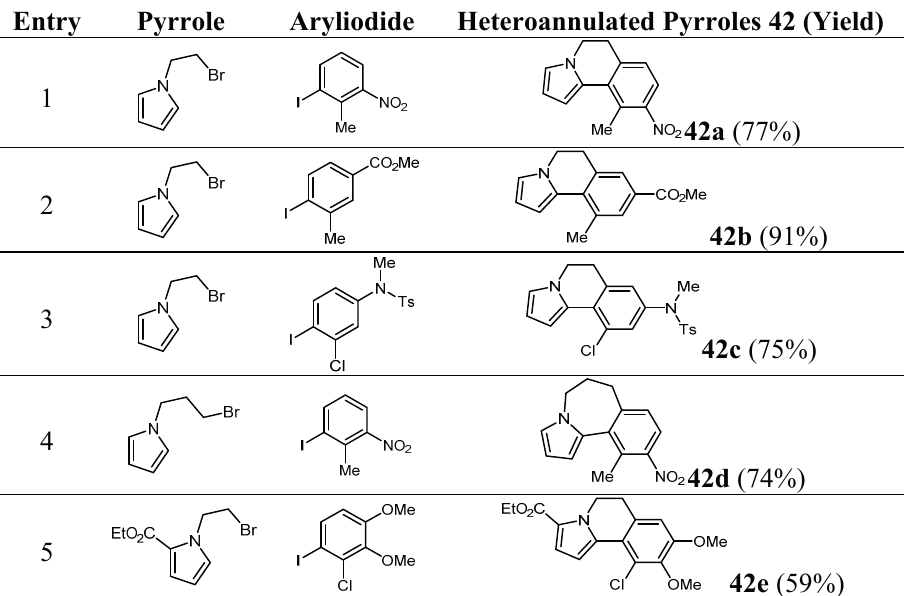
Table 13. Selected heteroannulated pyrroles 42 via sequentially Pd-catalyzed, norbornene mediated tandem alkylation direct arylation